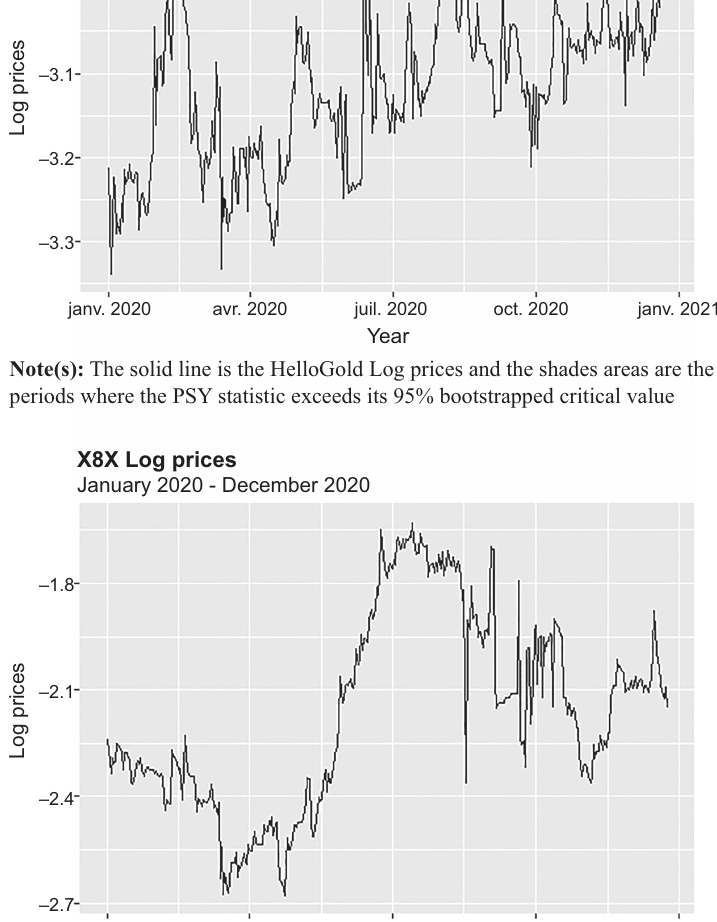
Figure 1. Islamic cryptocurrency